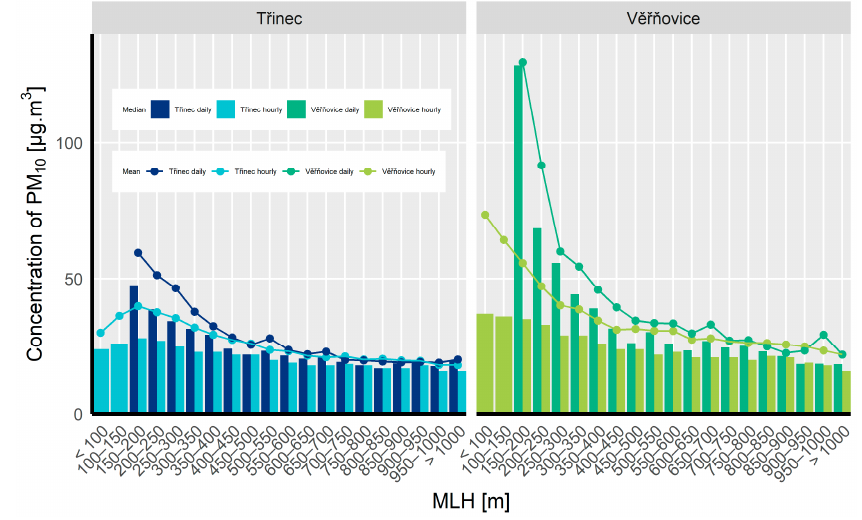
Figure 4. Hourly PM 10 concentration variability in relation to MLH, 2016–2019: ( a ) T ř inec-Kosmos; ( b ) V ěřň ovice.